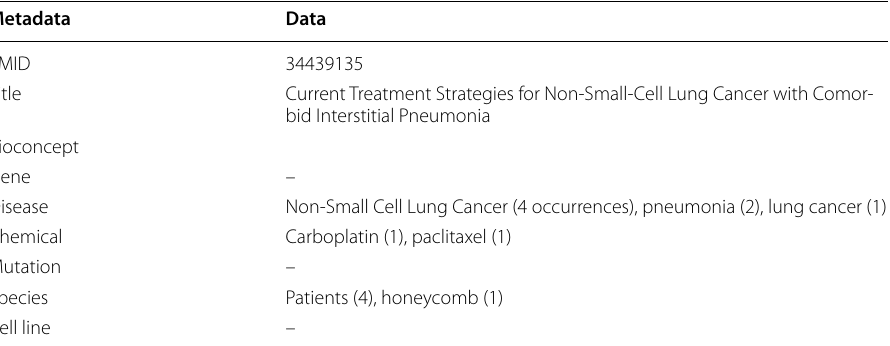
Table 2 Automatic bioconcept annotation from Pubtator